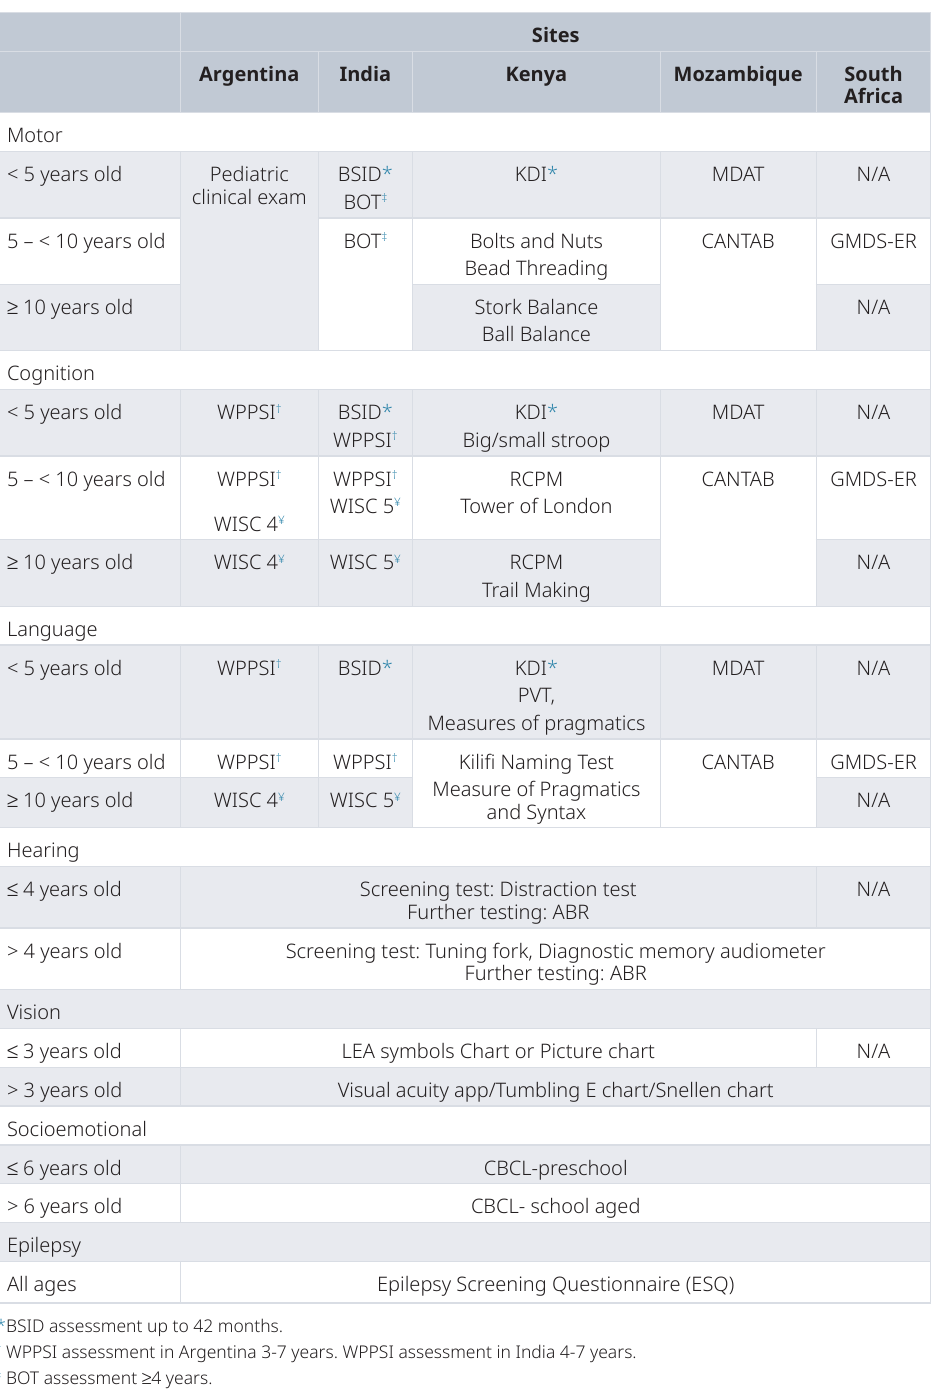
Table 4. Neurodevelopment assessment tools and other developmental assessment measures, by site and age.